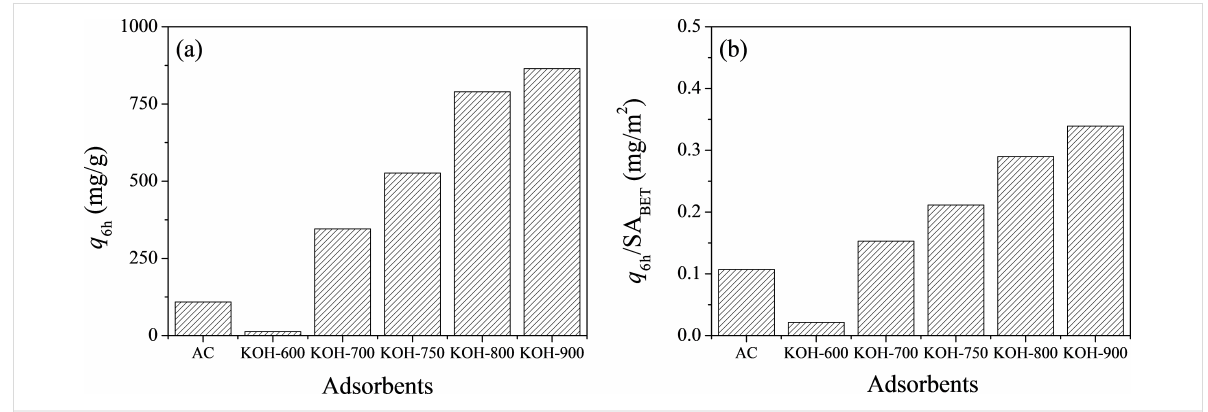
Figure 3: Adsorbed quantities of acid red 1 (AR1) over AC, KOH-600, KOH-700, KOH-750, KOH-800 and KOH-900 based on (a) unit weight and (b) unit BET surface area.